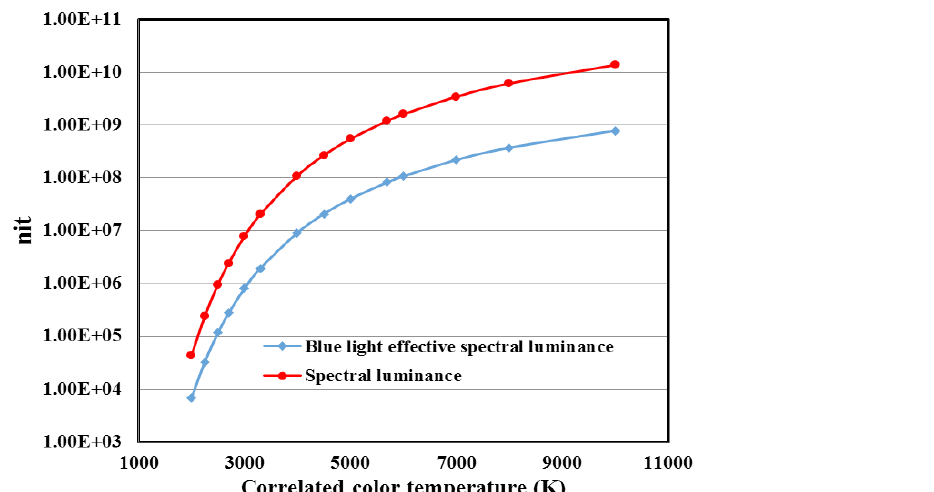
Figure 4. Calculated luminance and blue light effective luminance for the CCT range of 2000-10000 K using proposed photom- etry method